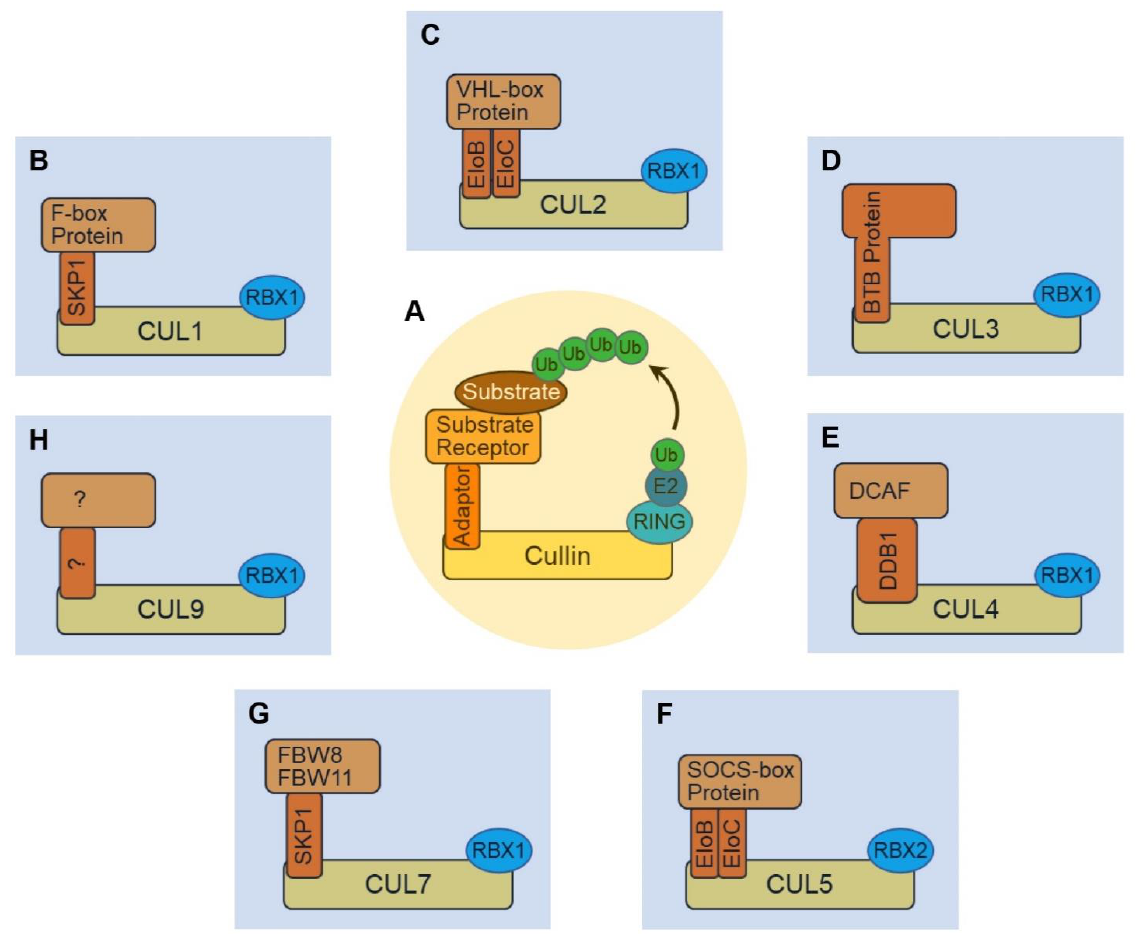
Figure 1. Schematic illustrating the structure of cullin-RING ubiquitin ligases (CRLs). ( A ) CRL complexes are modular. They all contain a cullin protein that serves as the backbone for the complex. A RING finger protein binds the C-terminus of cullin and serves as an adaptor for E2~Ub. The N-terminus of cullin recruits various substrate receptors—usually through an adaptor protein—to recognize and specify target substrates for ubiquitination. ( B ) The CUL1 • RBX1 enzymatic core of CRL1 uses SKP1 as an adaptor to recruit F-box proteins as substrate receptors. ( C ) CRL2 use EloB (elongin B) and EloC (elongin C) complex as the adaptor to recruit VHL-box proteins as substrate receptors. ( D ) CRL3 directly recruits BTB proteins without the need of an adaptor protein. ( E ) CRL4 (including CRL4A and CRL4B) uses DDB1 as the adaptor to recruit DCAF proteins as substrate receptors. ( F ) CRL5 is composed of CUL5 and RBX2, and it uses EloB and EloC complex as the adaptor to recruit SOCS-box proteins as substrate receptors. ( G ) CRL7 has been known to use the SKP1 adaptor protein to recruit FBW8 or FBW11 F-box protein substrate receptors. ( H ) CRL9 comprises CUL9 and RBX1, while the adaptor and substrate receptor complex remain